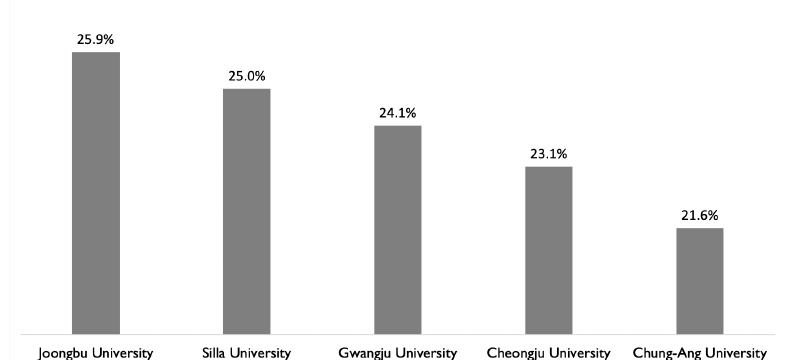
Figure 2. Top 5 universities with high frequencies of information-organization-related courses.